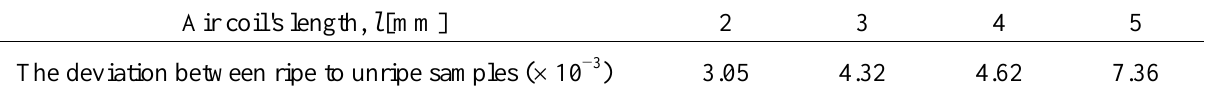
for air coil length versus coil diameter, r